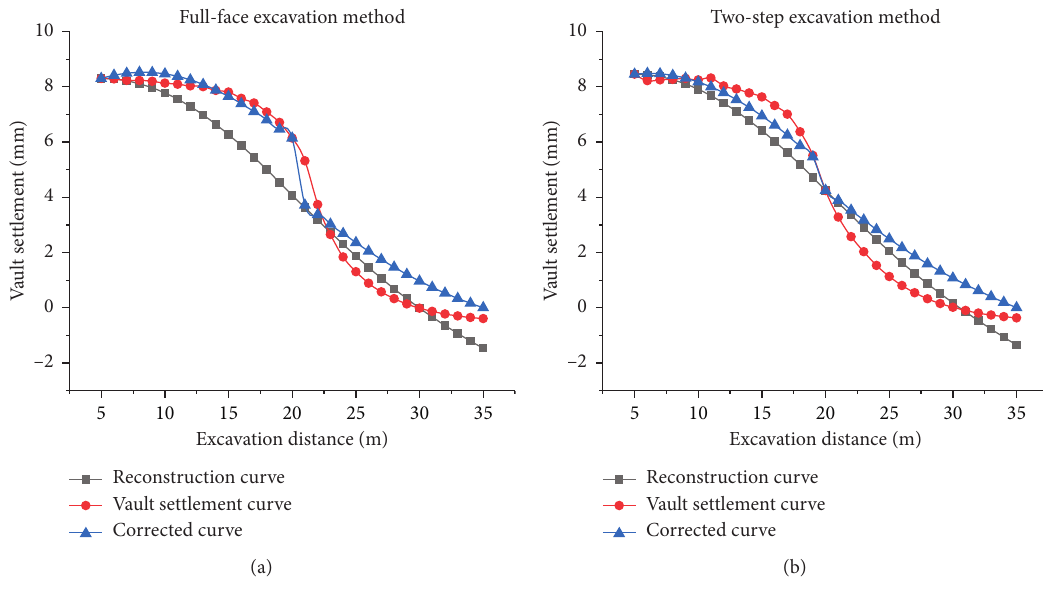
Figure 6: Displacement settlement